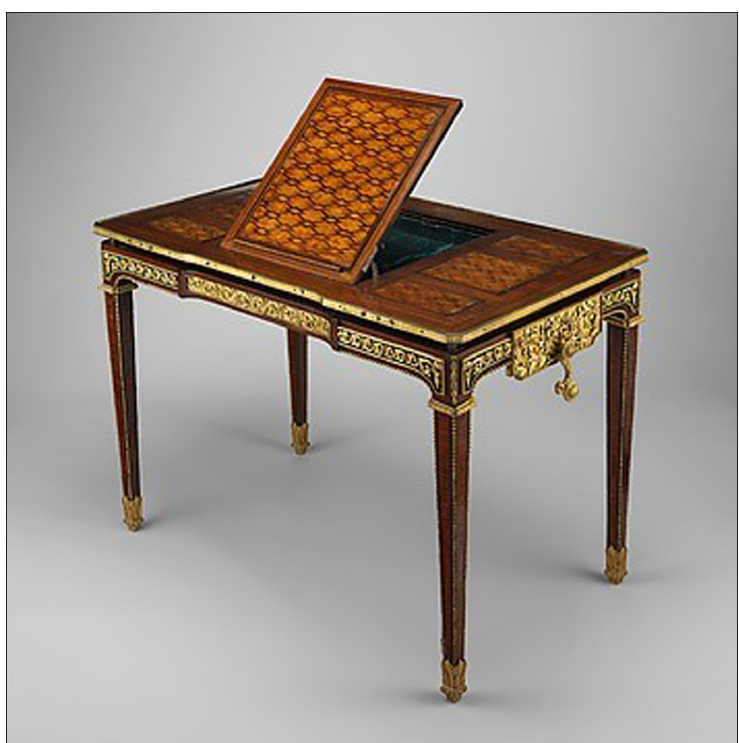
Fig. 4 : Jean-Henri Riesener, Mechanical table, Paris, 1778, oak, veneered with mar- quetry, gilt bronze, Metropolitan Museum of Art, New York (inv.